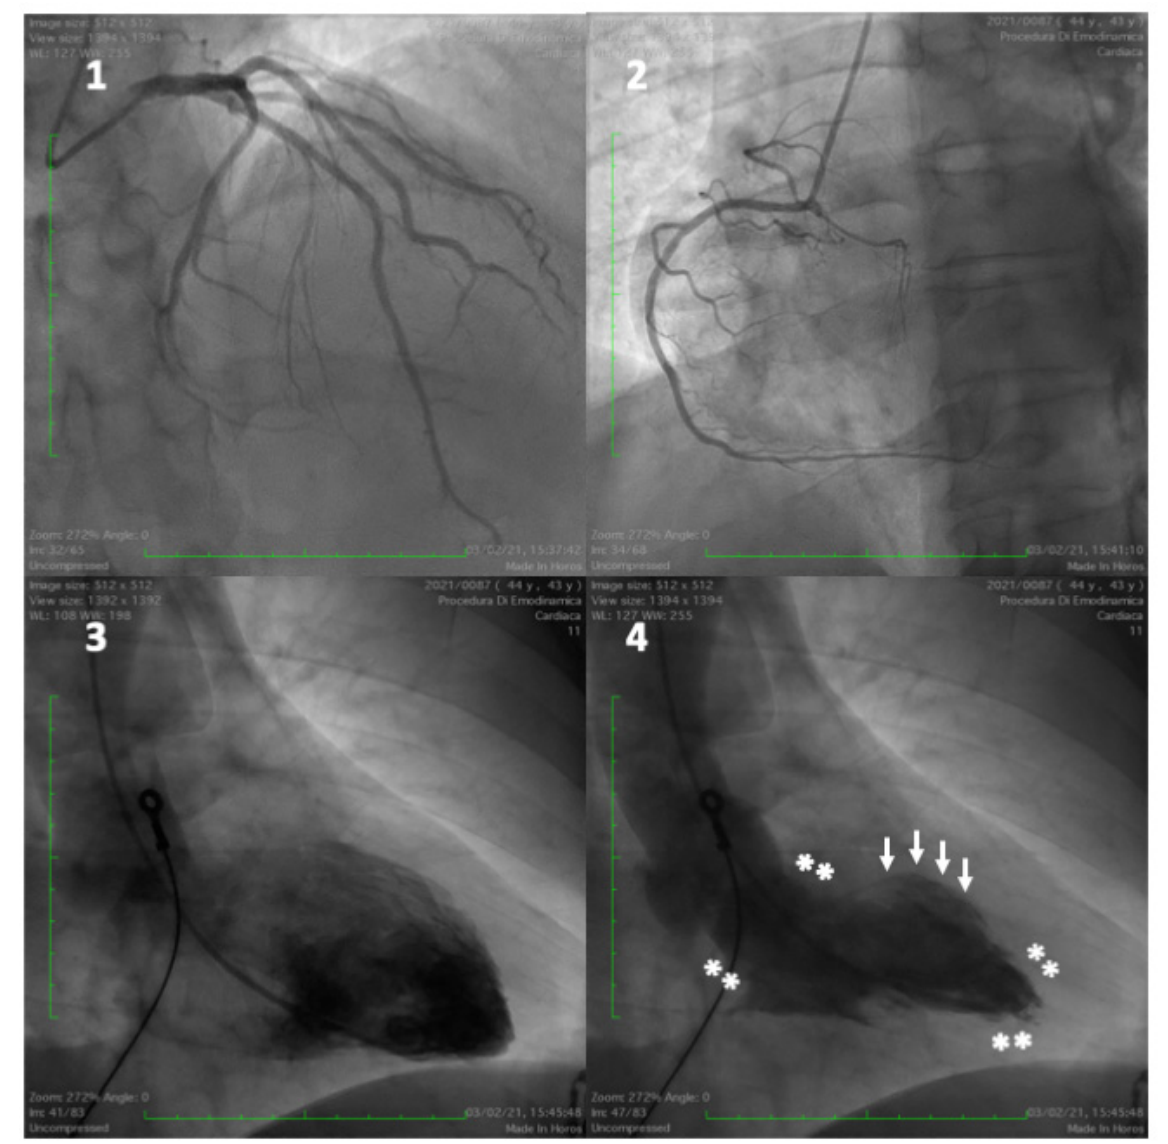
Figure 3. A 43-year-old man admitted for anterior ST-elevation myocardial infarction. Coronary angiography showed no coronary lesions on left and right coronary arteries (frames ( 1 ) and ( 2 )). Left ventriculogram (frames ( 3 ) and ( 4 )) showed hypercontraction of the basal segments and apex (frame ( 4 ), with asterisks) and akinesia in the mid segments (with arrows), typical for mid-ventricular Takotsubo cardiomyopathy.